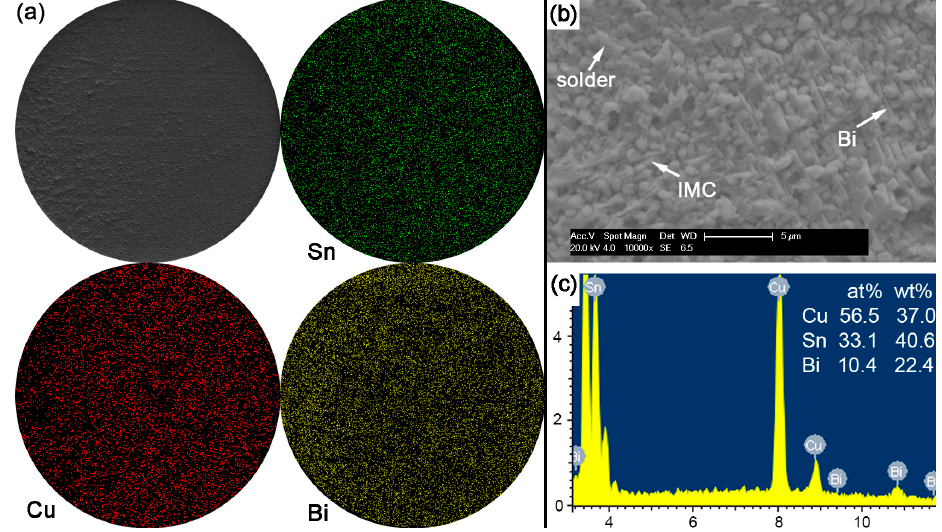
Figure 13. Fracture morphology of as-soldered Sn-30Bi solder bump: ( a ) SEM image and elemental mapping; ( b ) interfacial fracture at higher magnification; and ( c ) EDS analysis on image ( b ).